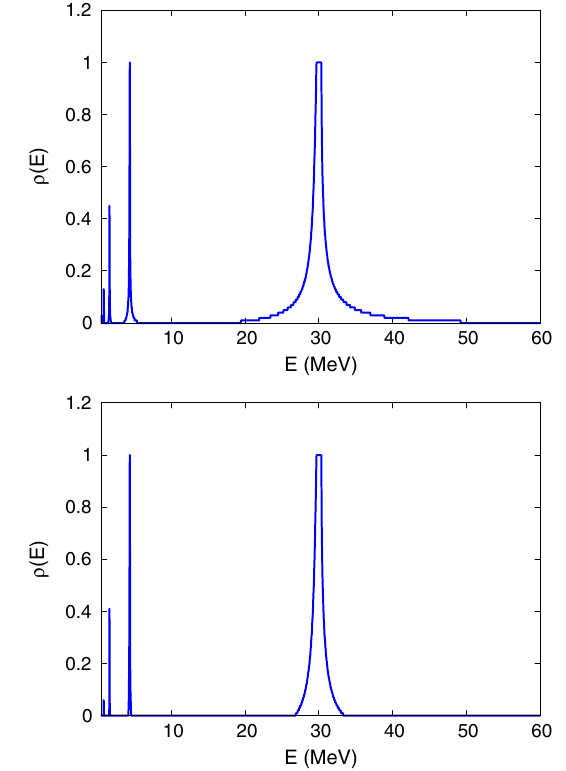
transmitted at a given energy through the collimator.